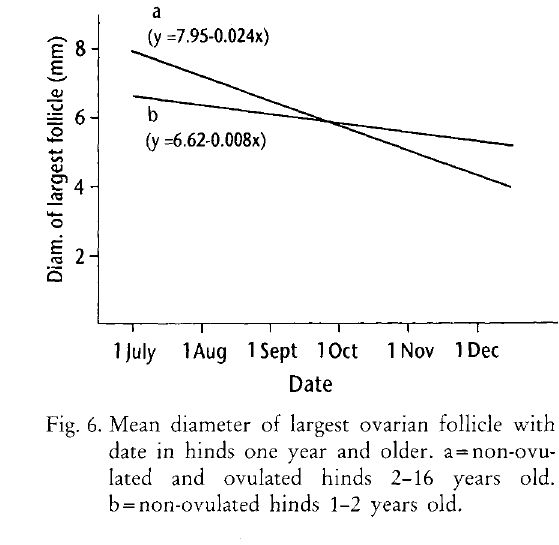
Fig. 6. Mean diameter of largest ovarian follicle with date in hinds one year and older. a = non-ovu- lated and ovulated hinds 2-16 years old. b = non-ovulated hinds 1-2 years